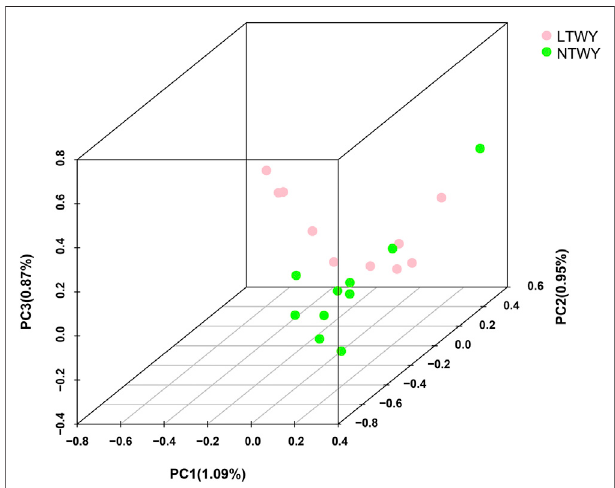
FIGURE 1 | Principal component analysis of NTWY and LTWY